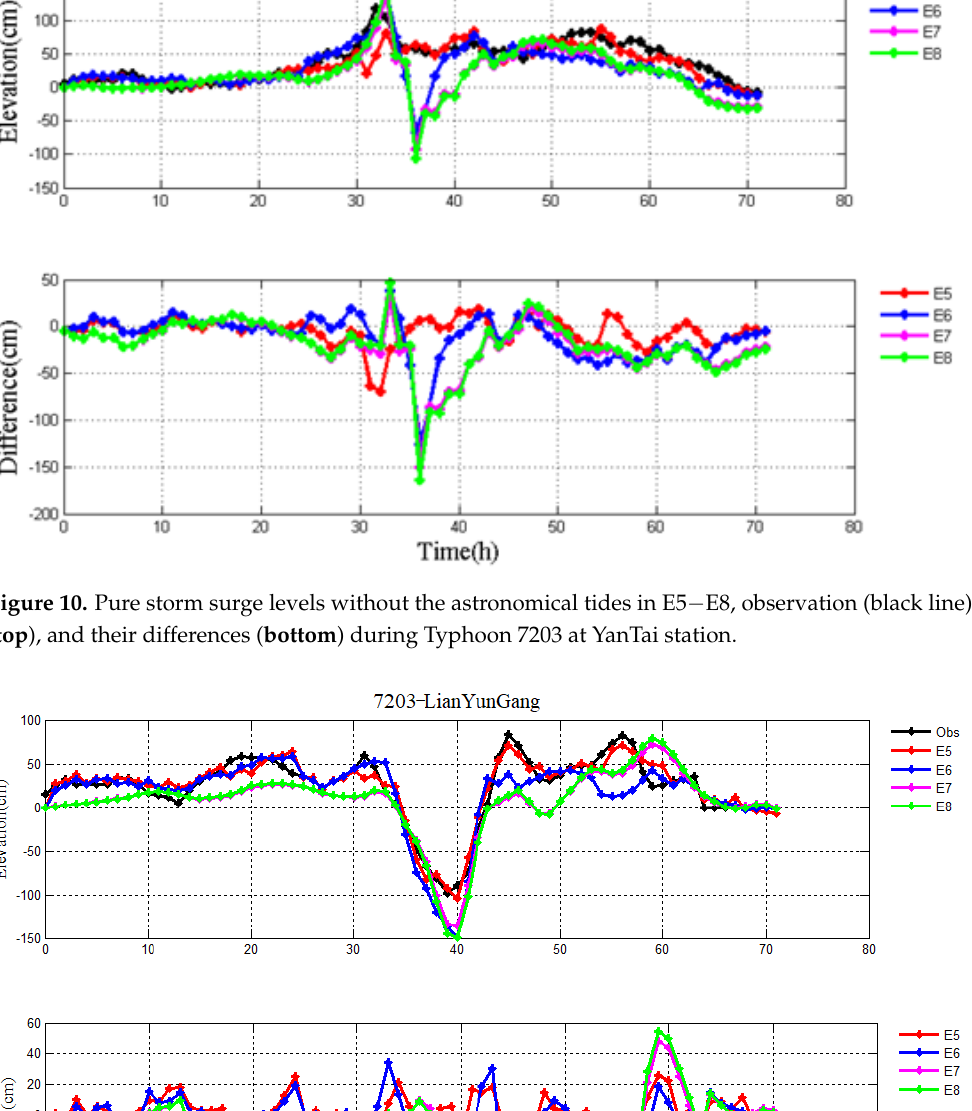
Figure 9. Spatially distributed levels calculated by the pure storm surge model in E5 – E8 at 20:00 am on 19 July 1973 during Typhoon 7303.